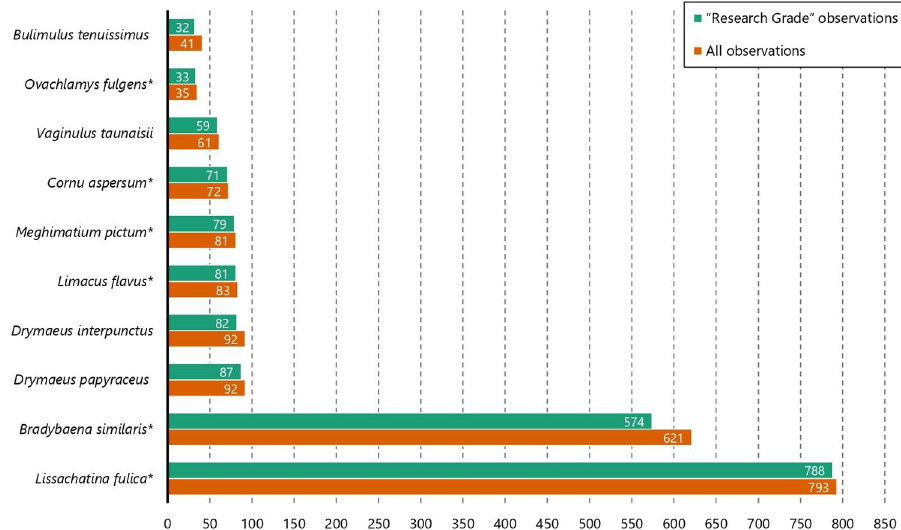
Fig 3. Breakdown listing of the top 10 terrestrial gastropods with the most observations published on iNaturalist in Brazil. “‘Research Grade’ observations” (after expert review) accounts for all observations listed as such on iNaturalist, while “all observations” contains all verifiable observations identified as each species. Exotic species are highlighted with an asterisk ( � ).